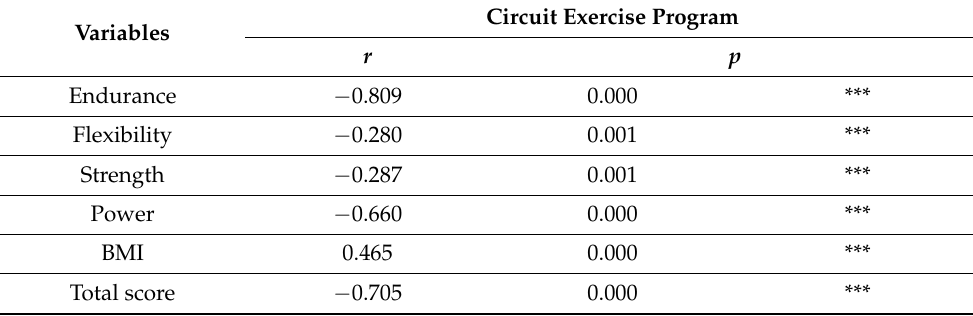
Table 6. Correlation between PAPS and